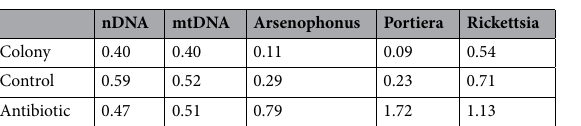
Table 3. Male: female ratio of qPCR targets quantities across three